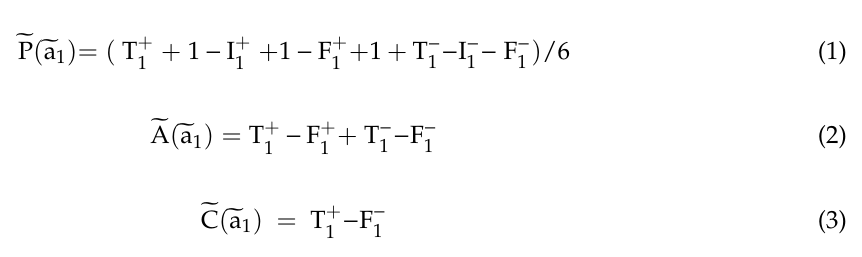
Table 3. Criteria for CEO selection.